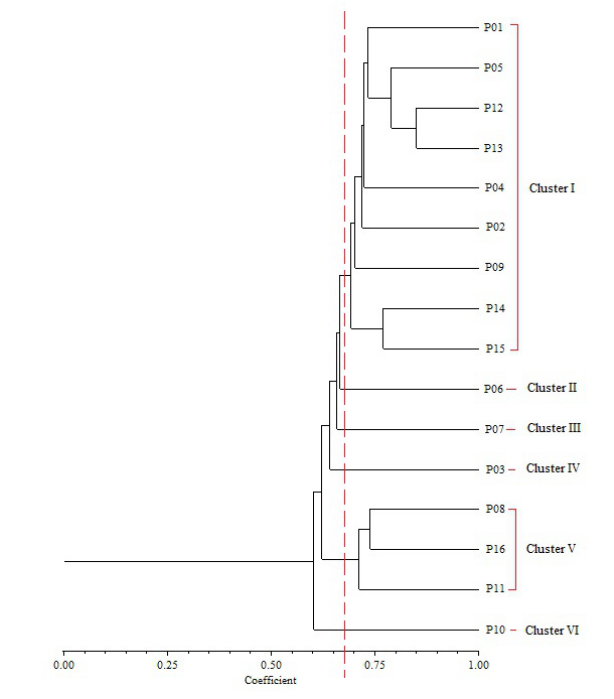
Figure 7. UPGMA dendrogram based on RAPD analysis of Parkia biglobosa